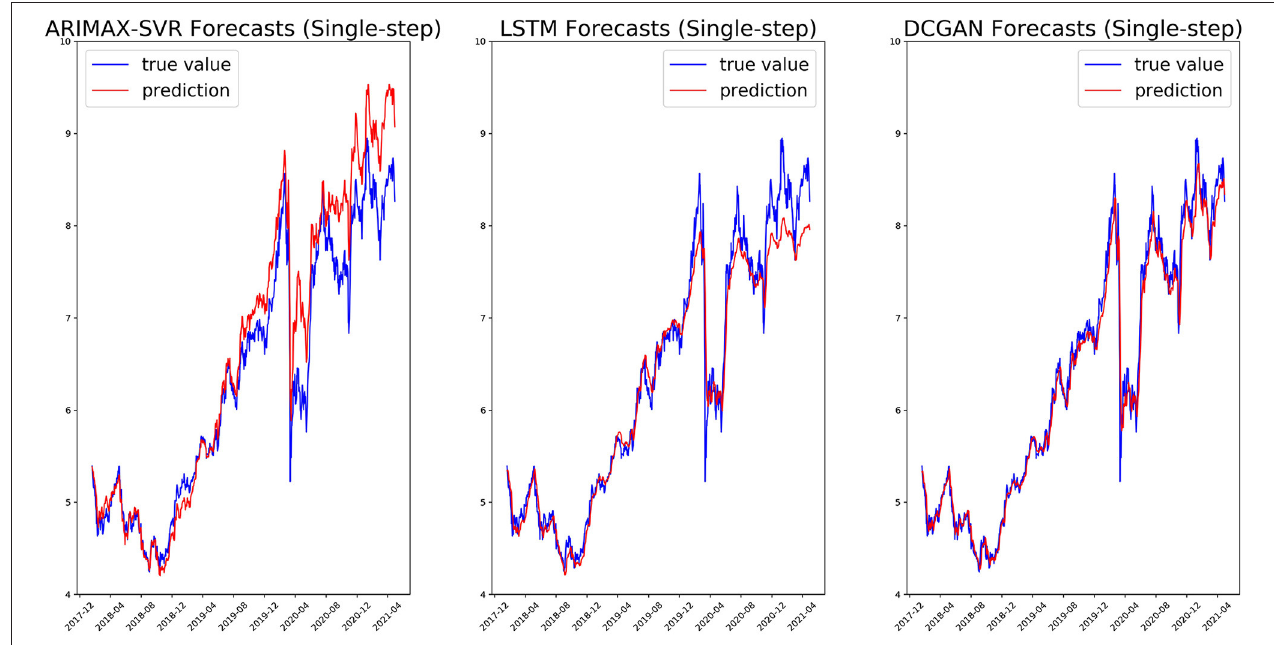
FIGURE 5 | Single-step forecasts on the ENEL test set for ARIMAX-SVR (left) , LSTM (center) , and our GAN architecture (right) .